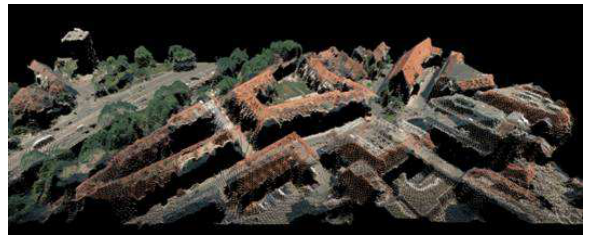
Figure 6. color-coded point cloud from Image Matching